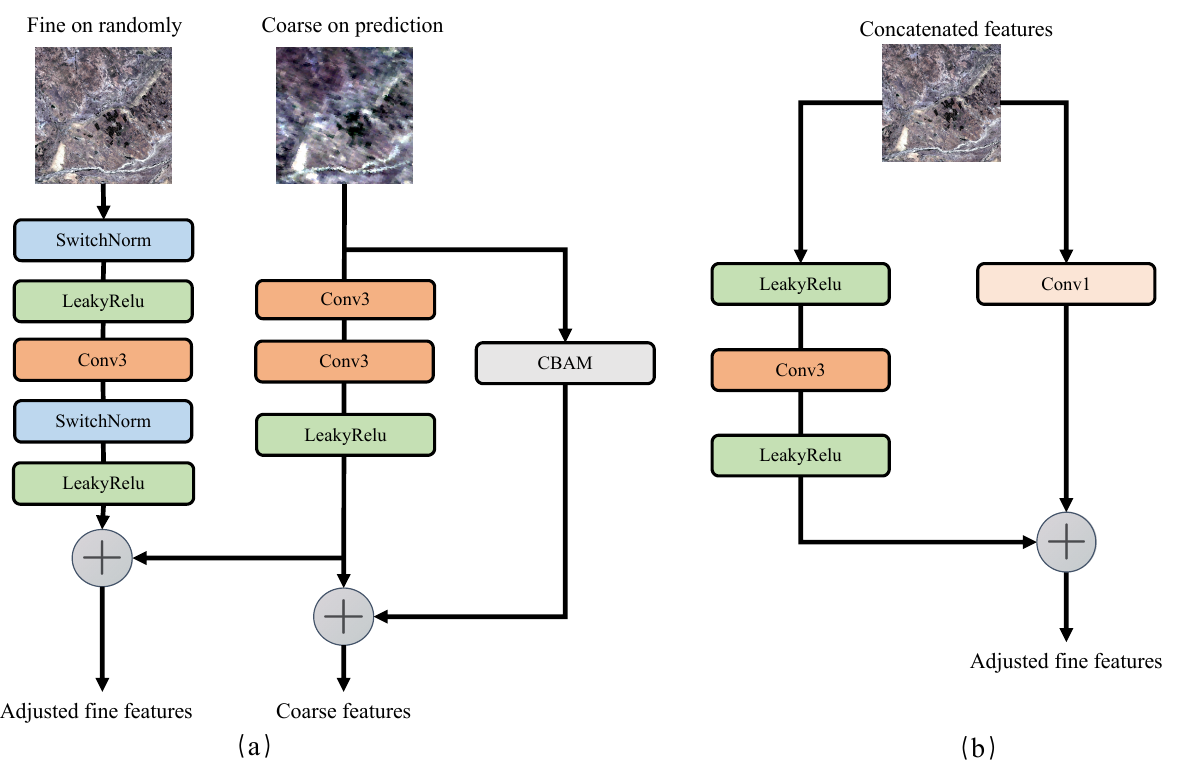
Figure 5. ( a , b ) Encoder structure diagram in generator structure. CBAM represents convolution block attention module, Conv3 represents 3 × 3 convolution operations twice to obtain coarser spectral information, Conv1 represents 1 × 1 convolution operation in the horizontal branch, mainly to adjust the channel of feature mapping to match the balanced